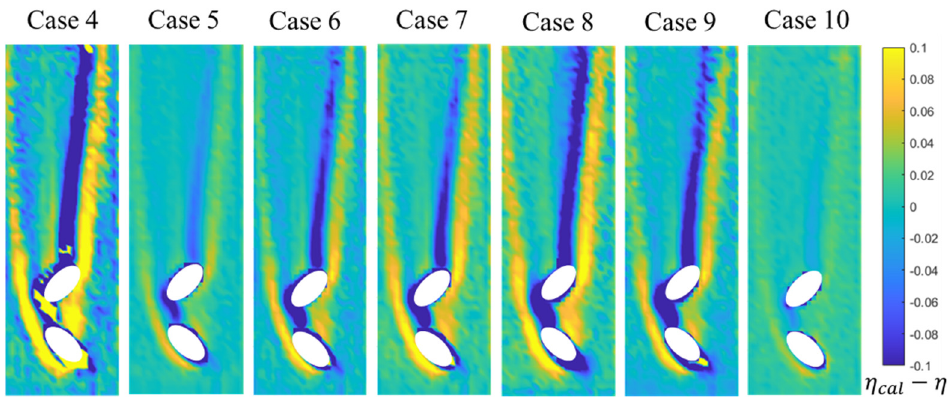
Figure 10. Errors of calculated film cooling effectiveness at M = 1.0.